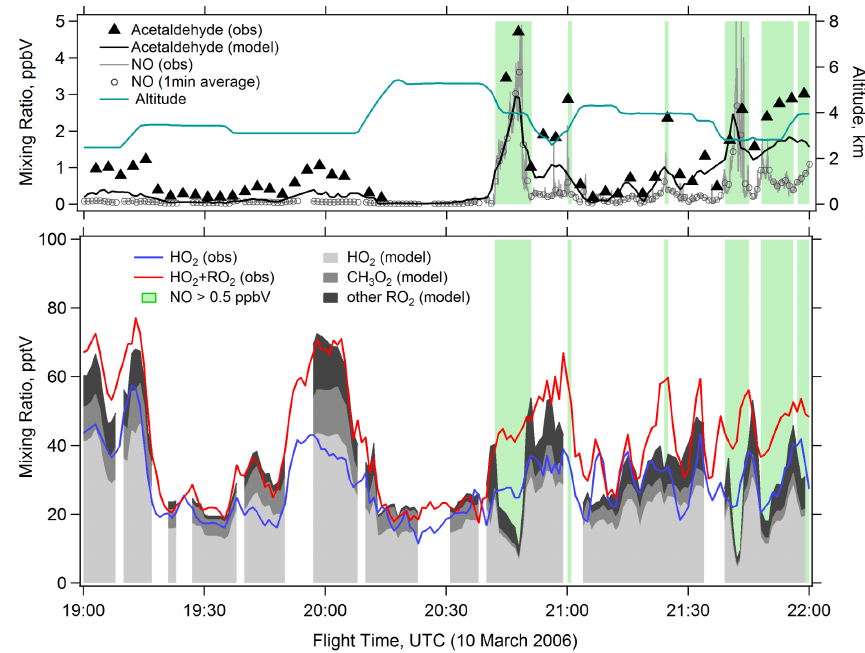
Fig. 9. Time-series plot of the observed and modeled acetaldehyde (top panel) and peroxy radicals (bottom panel) during a section of the flight on 10 March 2006. Local time in the flight region is UTC-6h. Grey areas defined in the legend on the lower plot are stacked modeled [HO 2 ], [CH 3 O 2 ] and non-CH 3 O 2 [RO 2 ]. The 1-s [NO] and 1-min [NO] are both included on the top panel, along with altitude. Time periods when the 1-min average [NO] is greater than 0.5ppbV are highlighted in green on both